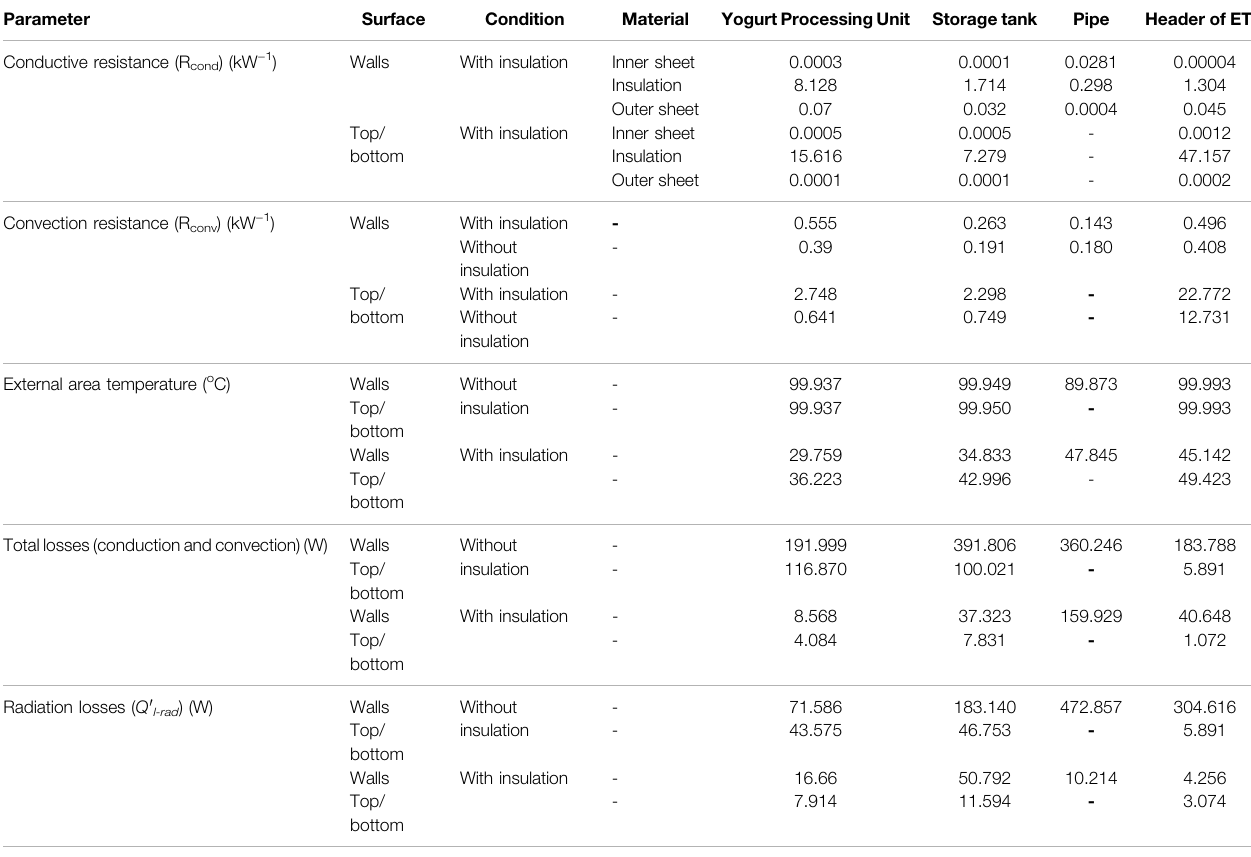
TABLE 2 | Parameters calculated for the thermal analysis of the current prototype of the solar assisted yogurt processing